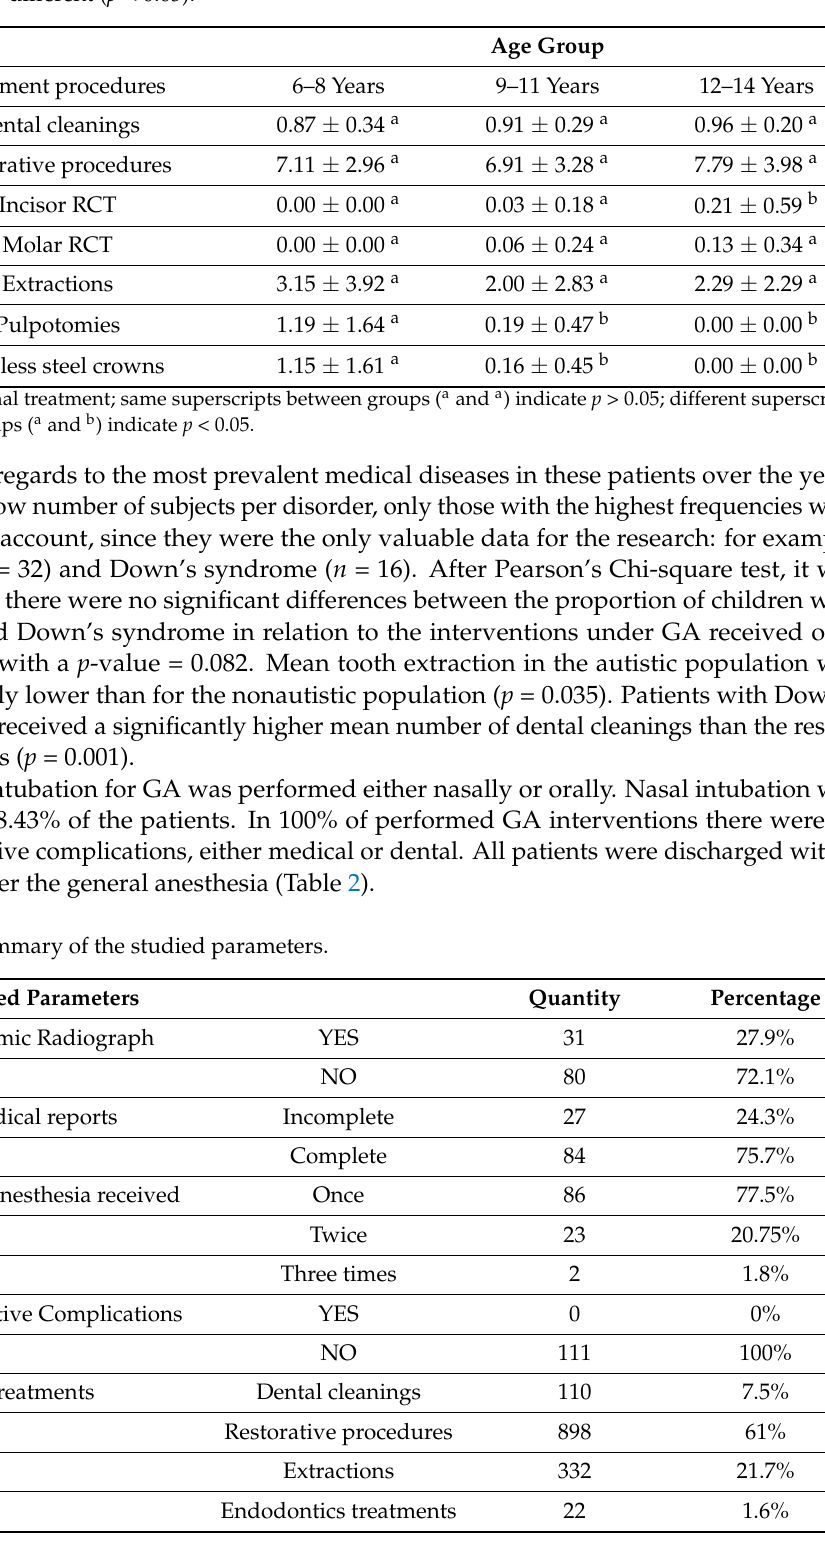
Table 1. Values are means ± standard deviation. Groups identified by different superscripts were significantly different ( p < 0.05).